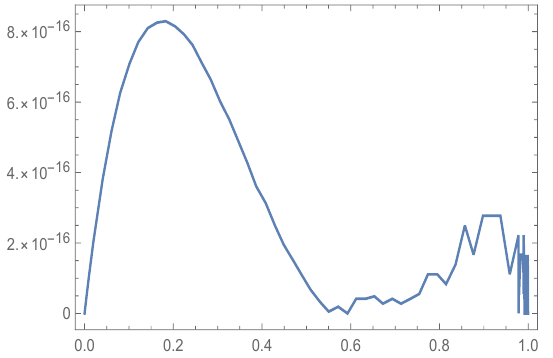
Figure 1. MAE of Z N ( x ) of our algorithm for υ 1 = 0.5 and N = 4 with b = 0 for Example 1.